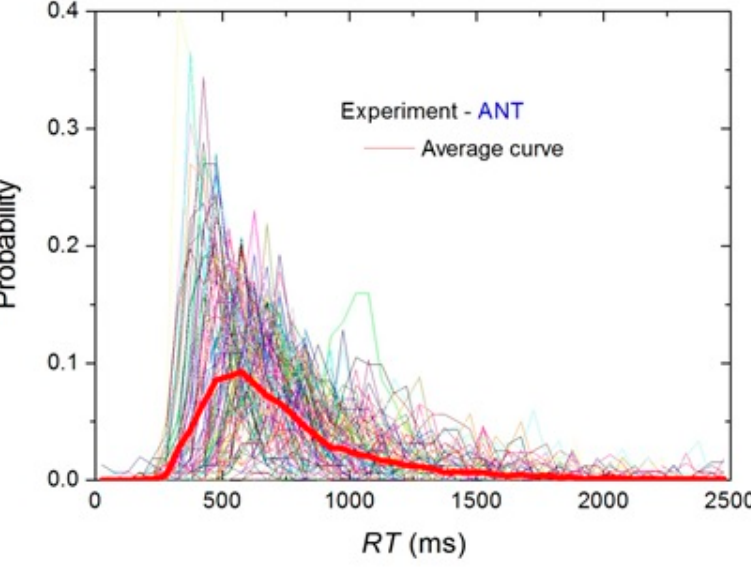
Figure 4. Probability distributions and average curve.